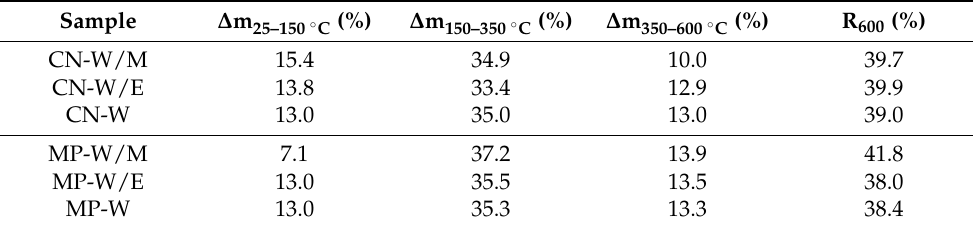
Table 4. Percantage mass losses ( ∆ m) of samples in various temperature ranges from 25 to 600 ◦ C and residue after thermal decomposition at 600 ◦ C (R 600 ).